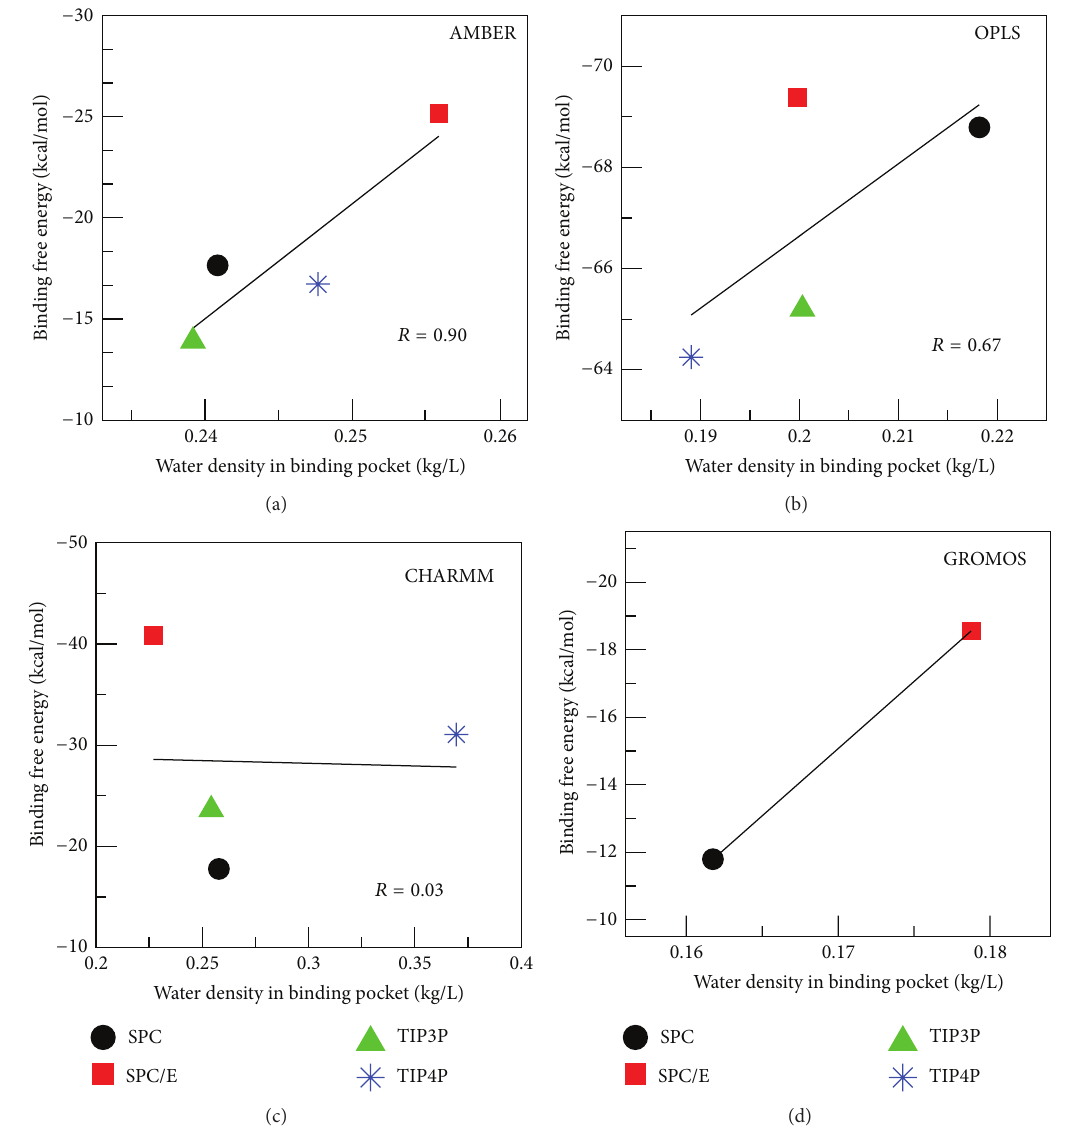
Figure 8: Δ𝐺 versus water density at the binding site in all force bind